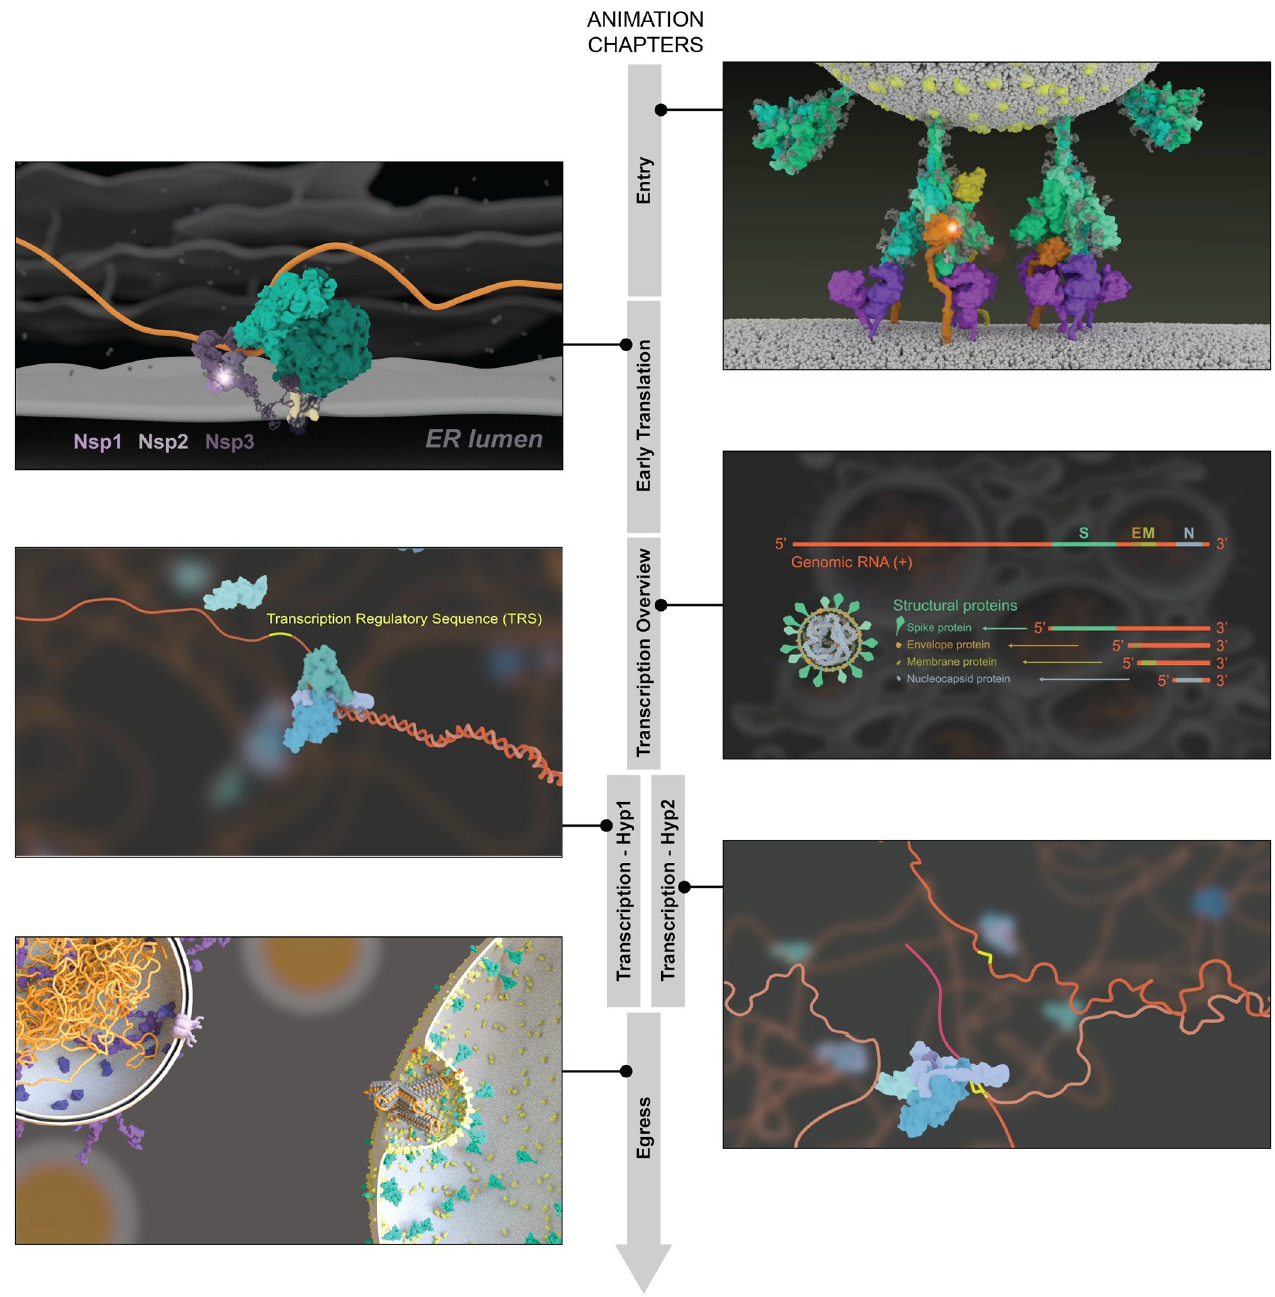
Fig 1. Representative still images from each of the chapters of the SARS-CoV-2 life cycle animation. Visit https://coronavirus-annotation-3.sci.utah.edu/ to watch the animation that is embedded in the annotation and commenting tool. If you’d like to download the animation or view it outside of the tool, you can do so on Vimeo: